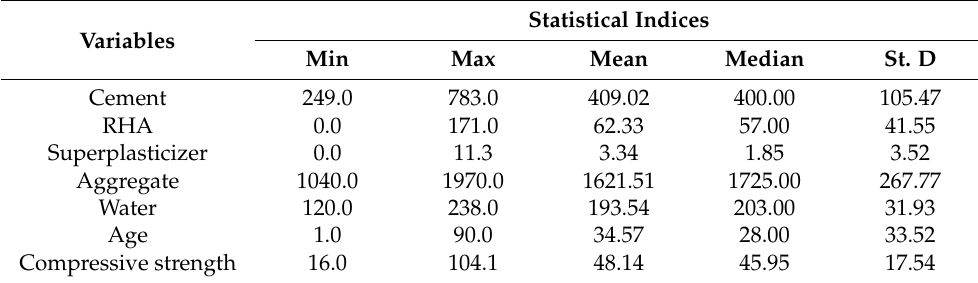
Table 1. Statistical information on each variable for predicting RHA concrete strength.